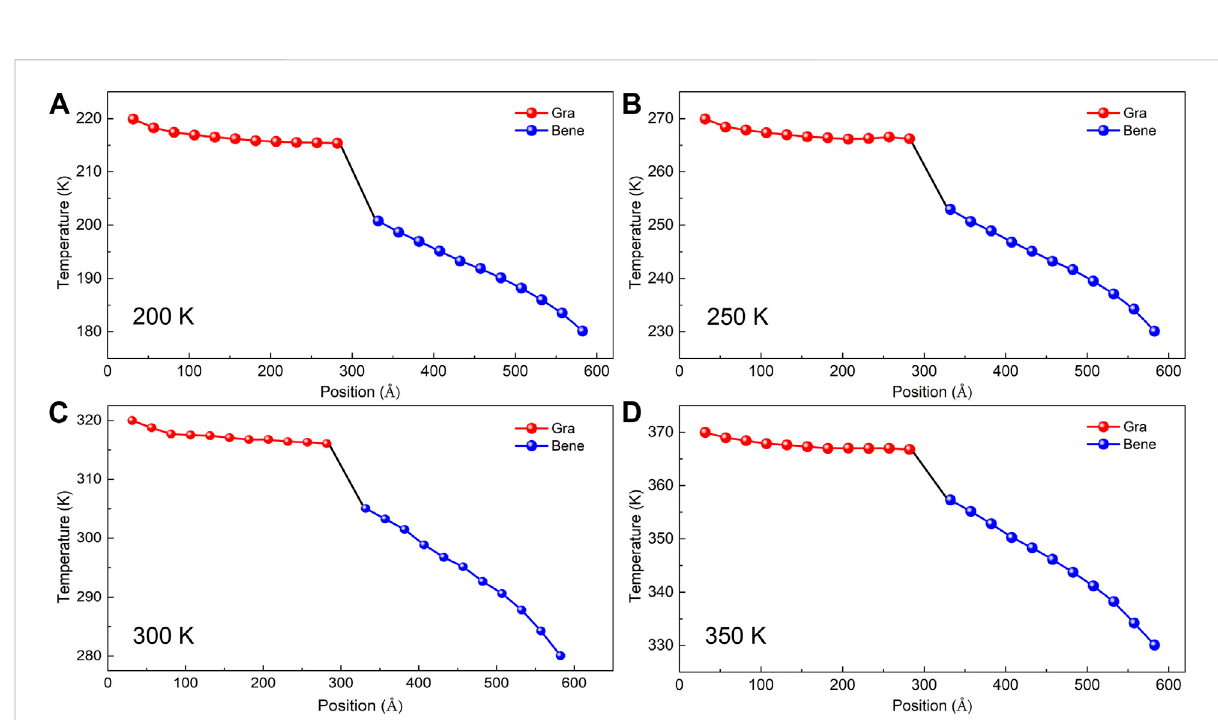
FIGURE 4 Temperature distribution of the biphenylene/graphene lateral heterostructure at (A) 200 K, (B) 250 K, (C) 300 K, and (D) 350